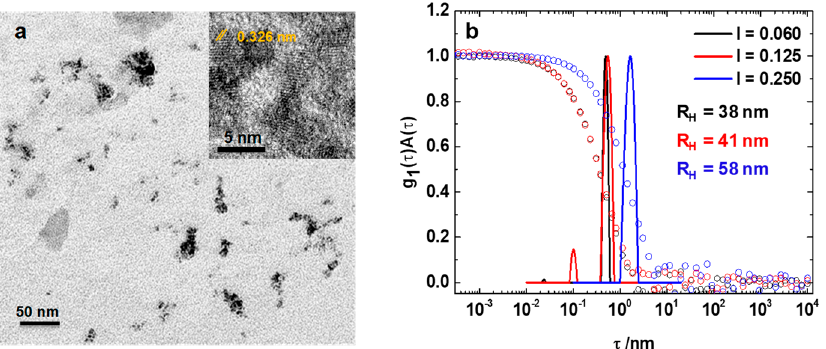
Figure 2. ( a ) TEM and HR-TEM image of PAA-capped CdS-ZnS nanoparticles, ( b ) dynamic light scattering: electric field autocorrelation function (dots) and distribution of relaxation times (lines) of CdS-ZnS-TAPP aggregates with charge ratio 0.060 (black), 0.125 (red) and 0.250 (blue).